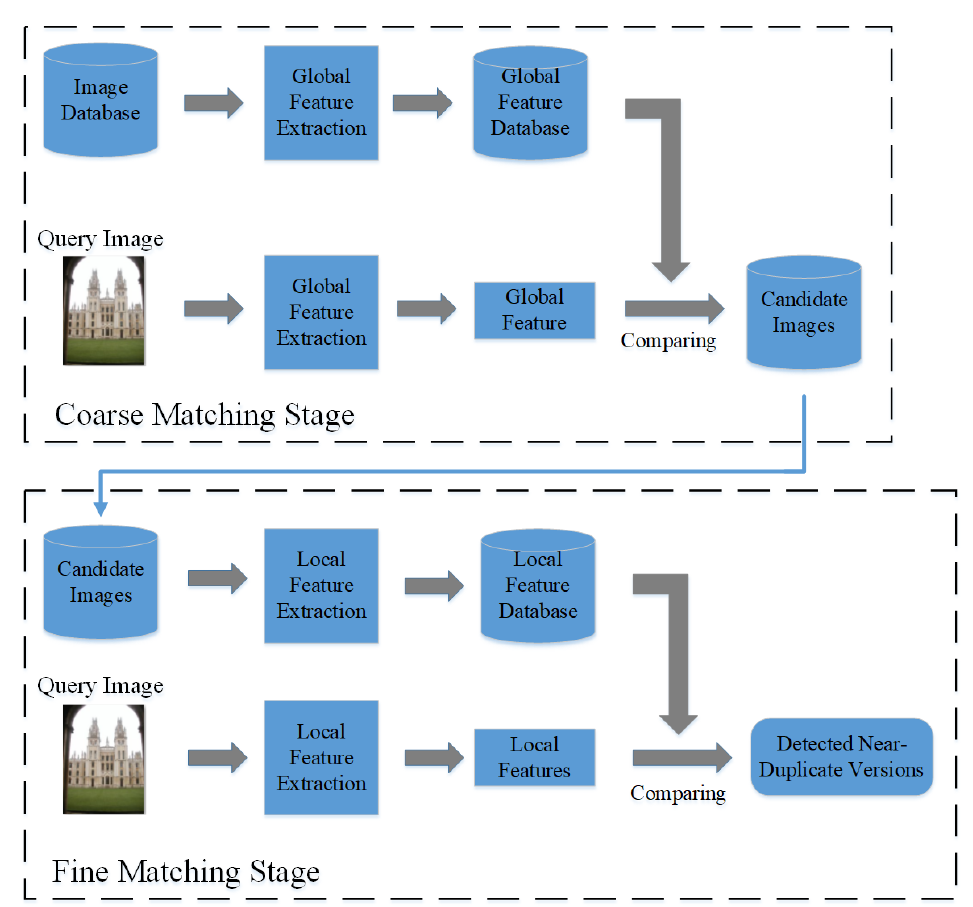
Figure 1. The framework of the proposed near-duplicate image detection system.